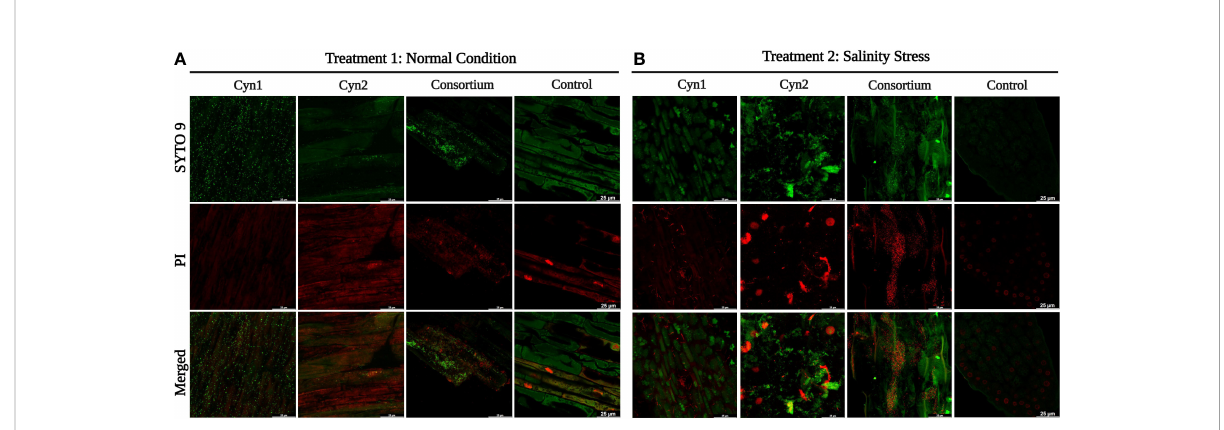
FIGURE 7 Confocal microscopy images showing root – bacteria association. Staining was done with SYTO 9/propidium iodide (LIVE/DEAD BacLight Bacterial Viability kit), and images were acquired at 60 x magni fi cation. (A) Treatment 1: normal condition. (B) Treatment 2: salinity